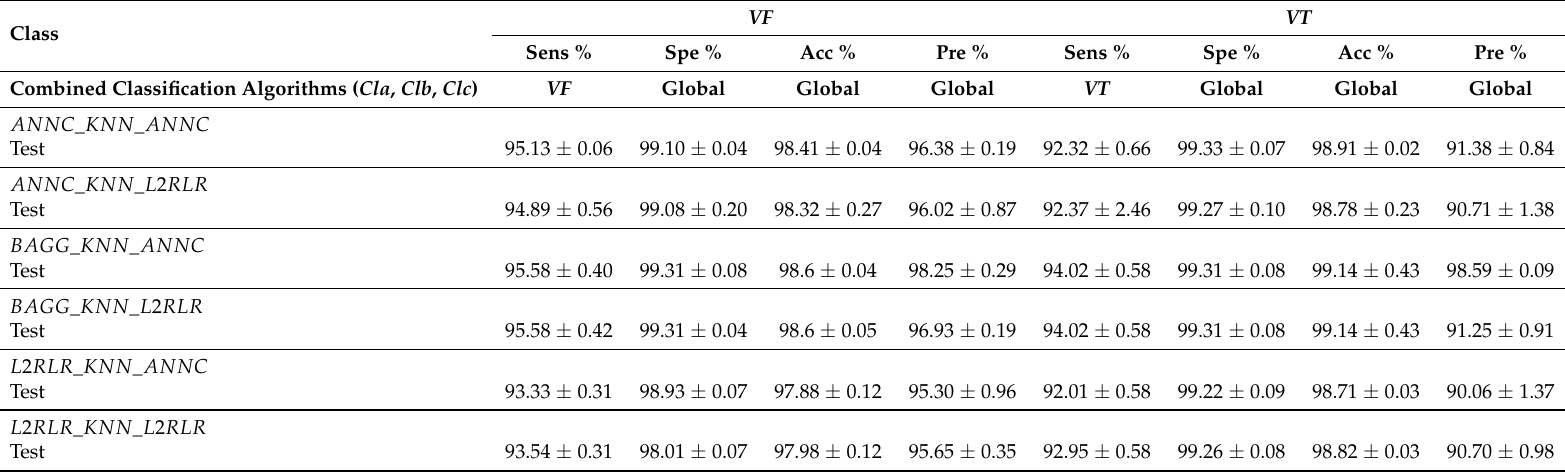
Table 9. Results for different hierarchical method (HM) combined classifier methods to detect VF and VT pathologies.